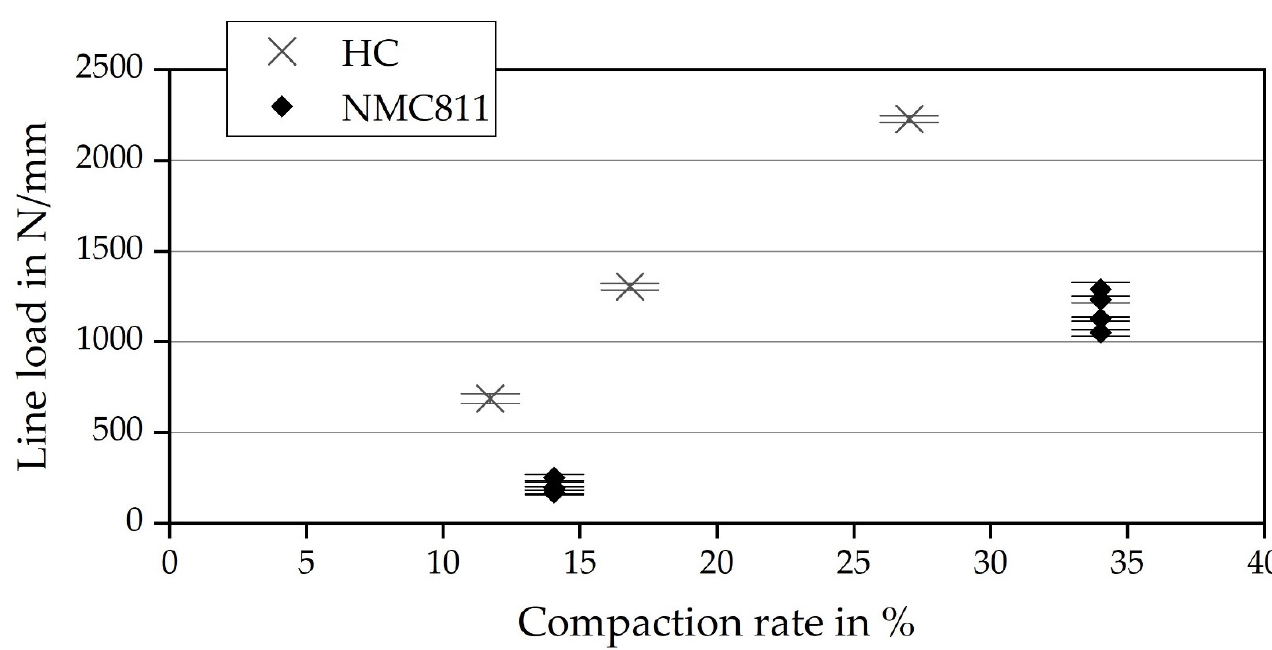
Figure 4. Material behavior regarding compactability at different line loads